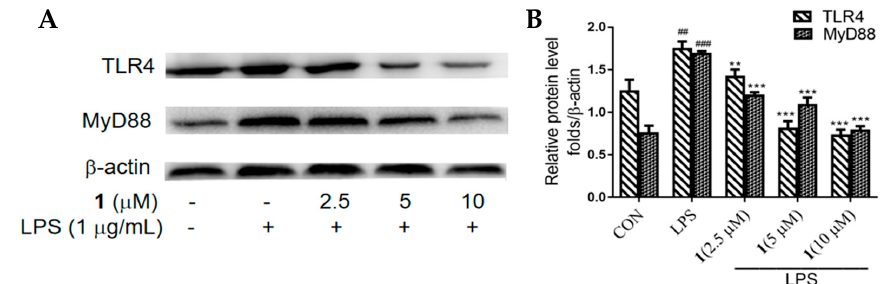
Figure 3. Effect of 1 on TLR4 and MyD88 expression in LPS-induced RAW 264.7 macrophages, as determined by Western blotting. Cells were incubated with various concentrations of 1 (2.5, 5 or 10 µ M) and LPS (1 µ g / mL) for 24 h. β -actin was used as the internal control. ( A ) Results are presented as representative of three independent experiments and summarized in the bar graphs. ( B ) Data are presented as means ± SD of three independent experiments. ## p < 0.01, ### p < 0.005 vs. control cells. ** p < 0.01, *** p < 0.005 vs. LPS-induced cells.